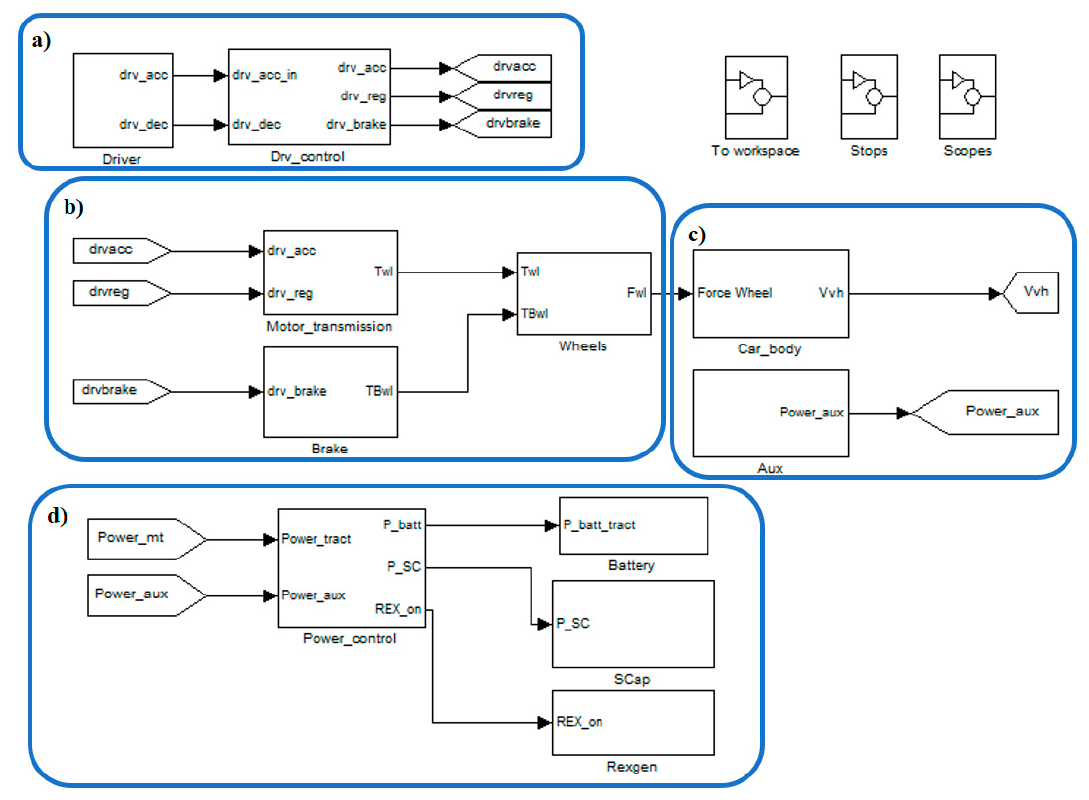
Figure 1. Layout of MATLAB-Simulink model: driver ( a ), powertrain ( b ), driveline ( c ), and energy management ( d ).